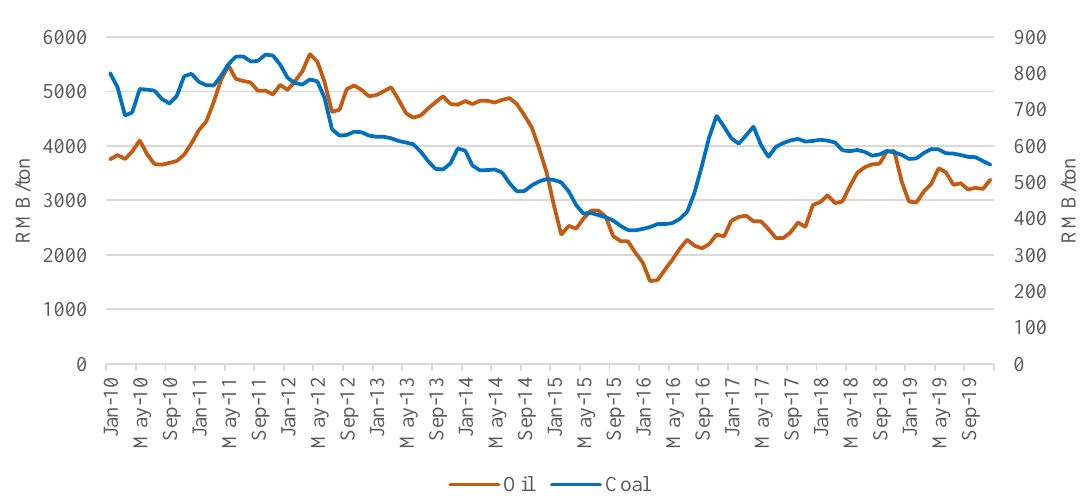
Figure 2. China coal and crude oil prices (January 2010–December 2019). Oil import price is shown on the primary axis; coal price is shown on the secondary axis. Data source: Datastream and